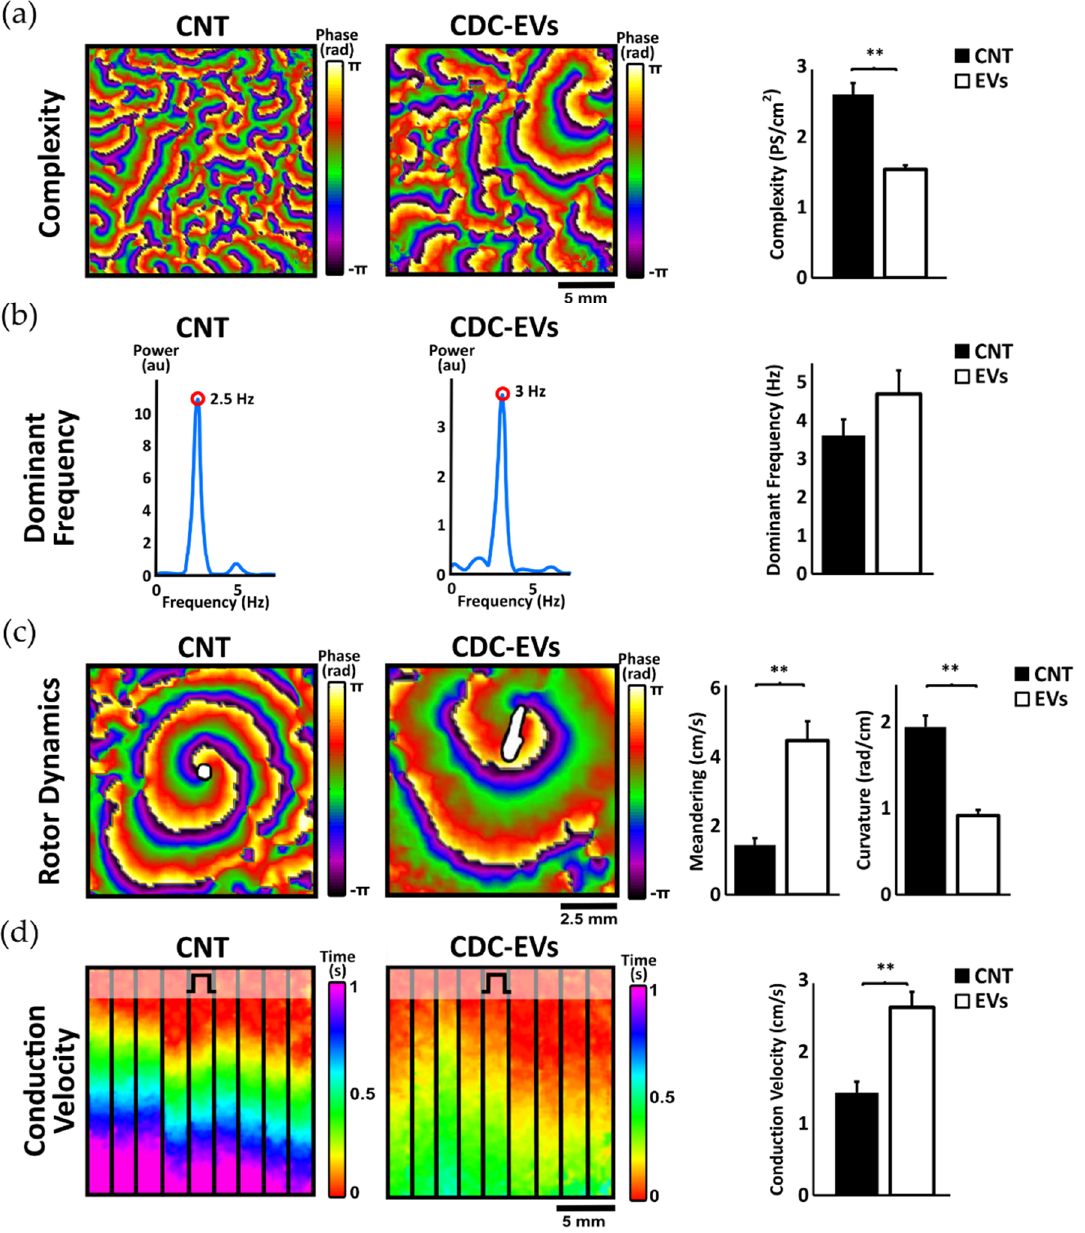
Figure 3. Electrophysiological characteristics comparison ( N = 12 in each group) and representative examples of control (CNT) and CDC-EV treated cultures. Examples of complexity, dominant frequency, rotor dynamics, and conduction velocity are illustrated for both groups. ( a ) Complexity was higher in the CNT vs. the CDC-EV group (** p < 0.01). ( b ) Average dominant frequency was not significantly different among both groups ( p > 0.05). ( c ) Rotor meandering was larger in the CDC-EV group vs. CNT (** p < 0.01), while curvature was smaller (** p < 0.01). ( d ) Conduction velocity was higher in the CDC-EV group (** p < 0.01). The isochrone map shows how the impulse took less time to travel the same distance in the CDC-EV group (500 ms) vs. the CNT group (1000 ms).